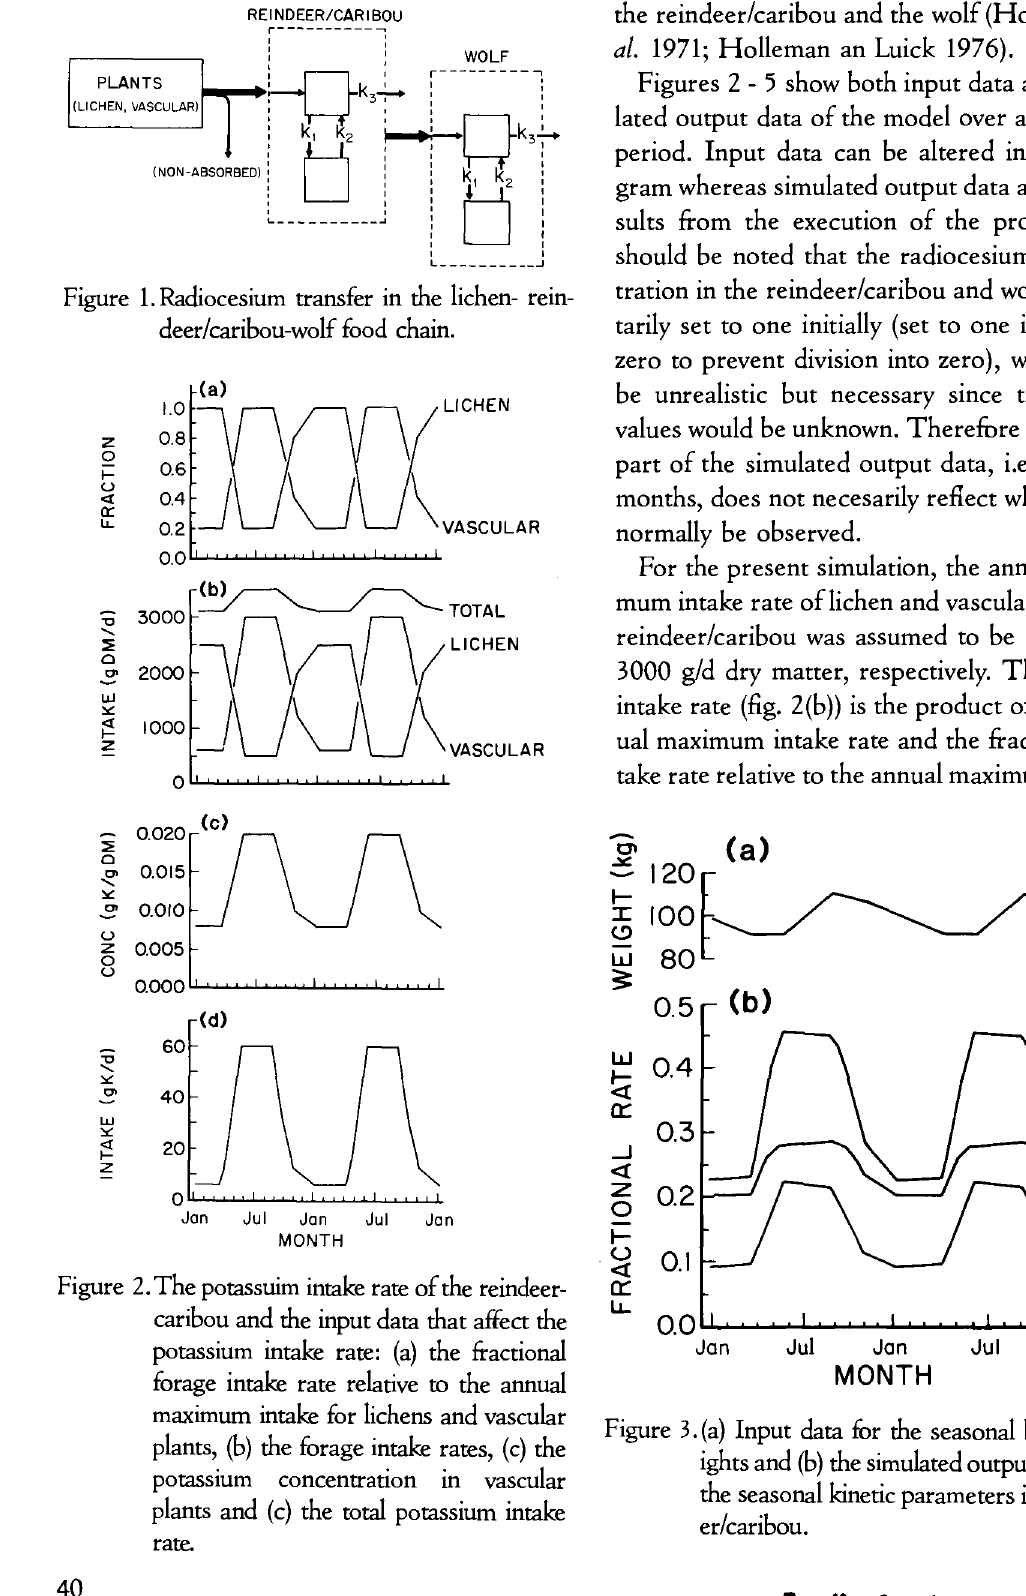
Figure 3.(a) Input data for the seasonal body we ights and (b) the simulated output data for the seasonal kinetic parameters in reinde